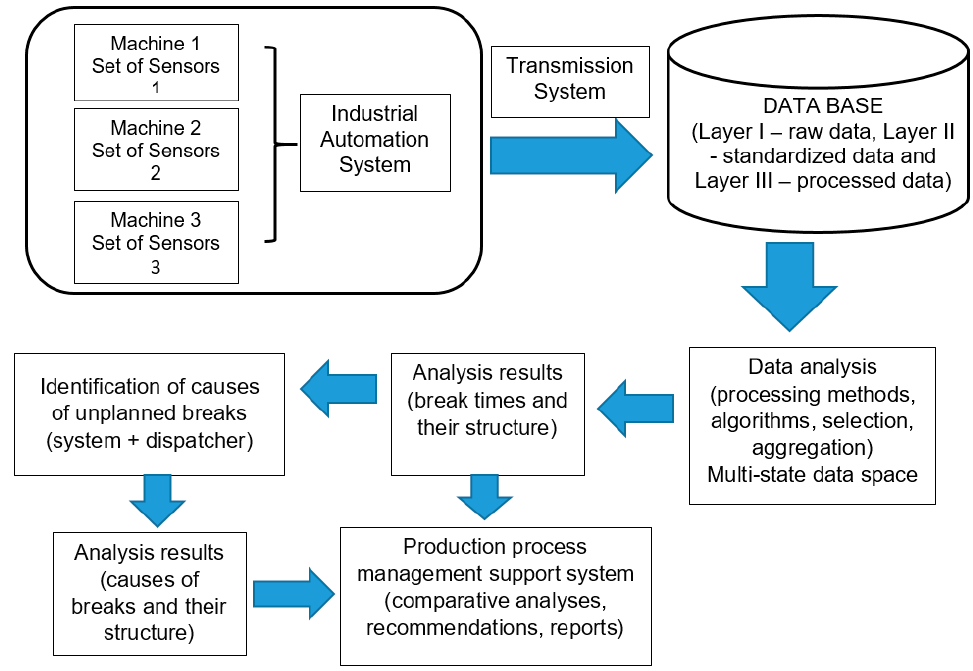
Figure 4. Diagram of the process of acquiring and using data on the parameters of machine operation to support their work management. to support their work